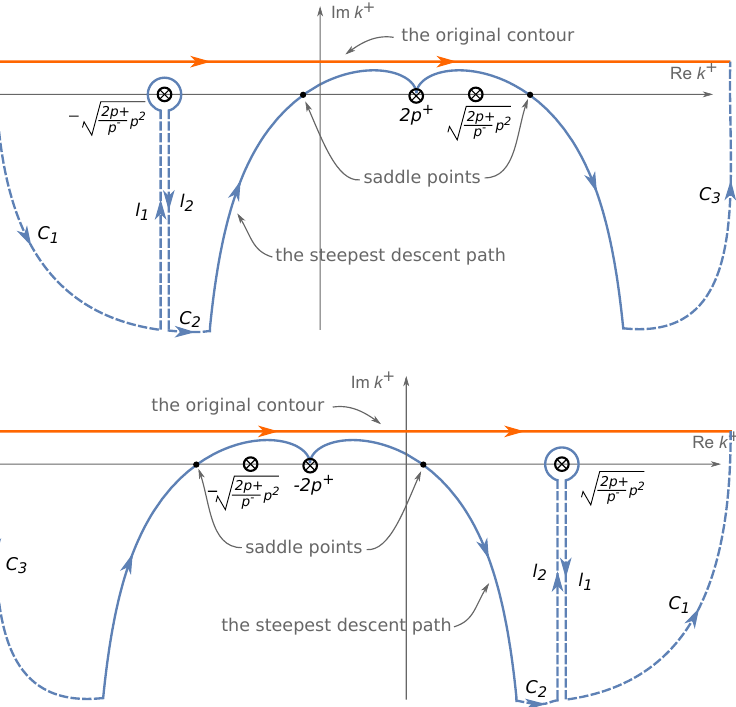
Figure 6 . Deformation of integration contours for the 1 st (top) and 2 nd (bottom) terms on the right- hand side of (4.3). In each (cid:12)gure, the original integration contour is a horizontal line in(cid:12)nitesimally above the real axis. It is deformed so that it continues along the steepest descent path. The contributions from integrating over l 1 and l 2 cancel with each other and the contributions from the arcs, C 1 , C 2 and C 3 , vanish as their radius goes to 1